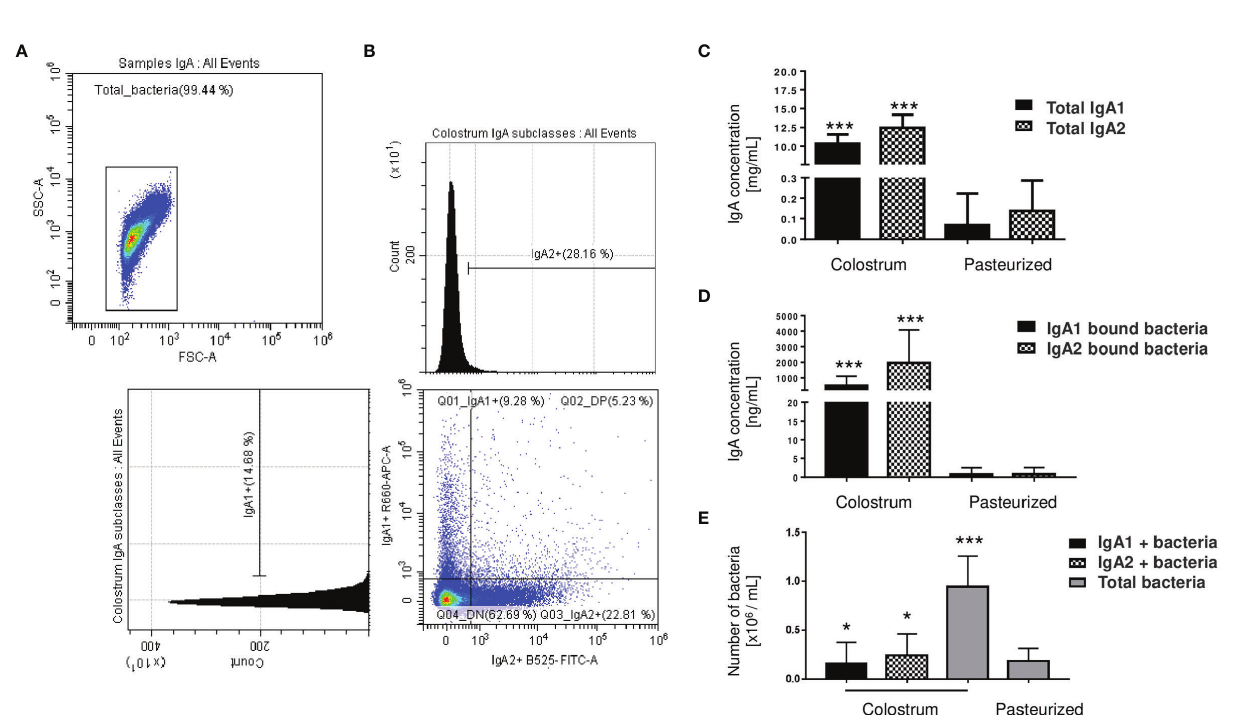
FIGURE 1 | Microbiota from the human colostrum is differentially coated with IgA subclasses. (A) Staining pro fi les of bacteria in human colostrum characterized by fl ow cytometry. (B) Analysis of bacterial populations by their associations with IgA1 (APC Cy7) and IgA2 (FITC) in human colostrum. Plots are representative of thirty- six biological samples analyzed. (C) Quanti fi cation of free IgA subclasses in colostrum, titled “ Colostrum, ” and pasteurized milk, titled “ Pasteurized ” : by ELISA. Data are expressed in milligrams of IgA subclasses per milliliter of the sample (mg/mL). (D) Semi-quanti fi cation by Western blot of IgA subclasses ’ levels bound to bacteria, data are expressed in nanograms of IgA subclasses per milliliter of the sample (ng/mL). IgA1 (black bars) and IgA2 levels ( fi lled bars) from Colostrum and Pasteurized milk. (E) Numbers of bacteria determined by fl ow cytometry. Data are expressed in millions of bacteria per milliliter of the sample (10 6 bacteria/mL). IgA1+ (black bars), IgA2+ ( fi lled bars) and total bacteria (gray bars). Bars indicate the mean ± SD of triplicates from thirty-six “ Colostrum ” and twenty-eight “ Pasteurized ” milk samples. Statistical analysis was performed using the Mann-Whitney U test, comparing each IgA subclasses level with the pasteurized milk sample as a control. *p < 0.05 and ***p <